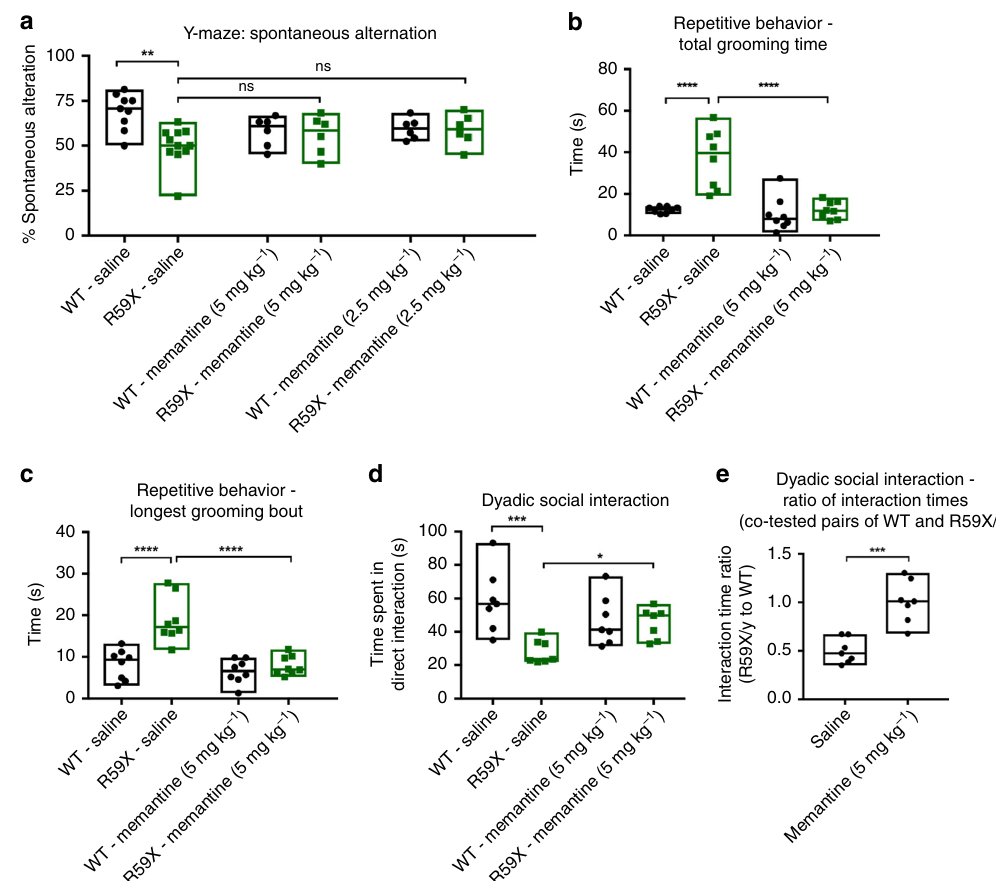
Fig. 7 Acute NMDAR blockade ameliorates autistic-like features, but not learning and memory, in CDKL5-de fi cient mice. a Spontaneous alternation percentage is signi fi cantly reduced in saline-treated R59X mice in comparison to WT mice. However, acute memantine administration at either 2.5 or 5